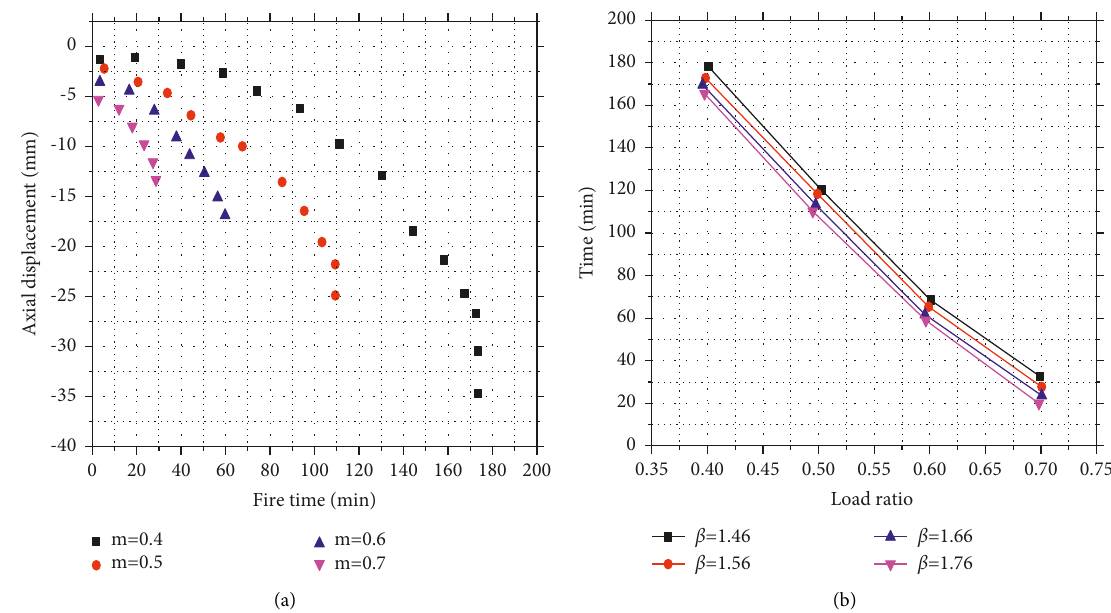
Figure 5: Analysis results of different load ratios of steel body. (a) Variation diagram of lateral displacement of middle column top when the bottom layer is in the fire; (b) fire resistance rating curve of steel frame under different load ratios.